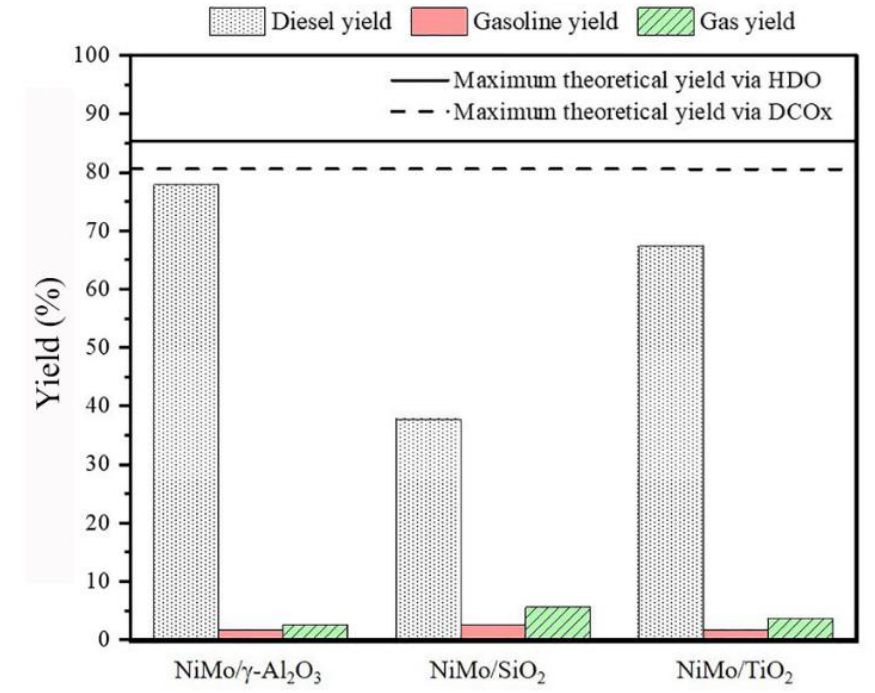
Figure 5. The diesel yield, gasoline yield, and gas yield of NiMo/ γ -Al 2 O 3 , NiMo/SiO 2 , and NiMo/TiO 2 catalysts. All experiments were conducted at a temperature of 330 ◦ C, H 2 pressure of 50 bar, WHSV = 1.5 h − 1 , and H 2 /oil ratio = 1000 cm 3 /cm 3 . The hydrocarbon distribution in the liquid product of sulfided NiMo/ γ -Al 2 O 3 , NiMo/SiO 2 , and NiMo/TiO 2 catalysts is summarized in Table 4. n -C 17 and n -C 18 hydrocarbons are predominant hydrocarbon compositions corresponding to oleic acid, the main feed compo- sition. Higher n -C 18 (>50 wt.%) was observed over the γ -Al 2 O 3 and TiO 2 support catalysts, suggesting that HDO reaction is preferred for these two catalysts. On the other hand, DCO and DCO 2 pathways were enhanced over the sulfided NiMo/SiO 2 catalyst as evidenced by the high amount of n -C 17 (>60 wt.%) in the liquid product. This result can also explain the highest gas yield produced over the SiO 2 -support catalyst due to the elimination of oxygen atoms in triglycerides and fatty acids in the forms of CO and CO 2